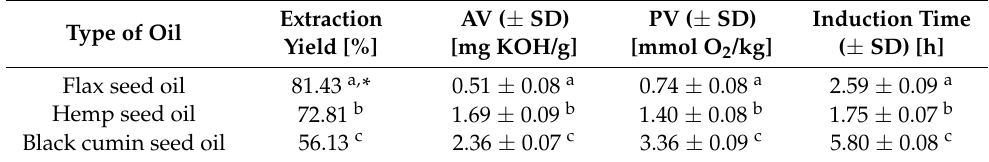
Table 3. Extraction yield and chemical properties of fresh cold-pressed oils. Type of